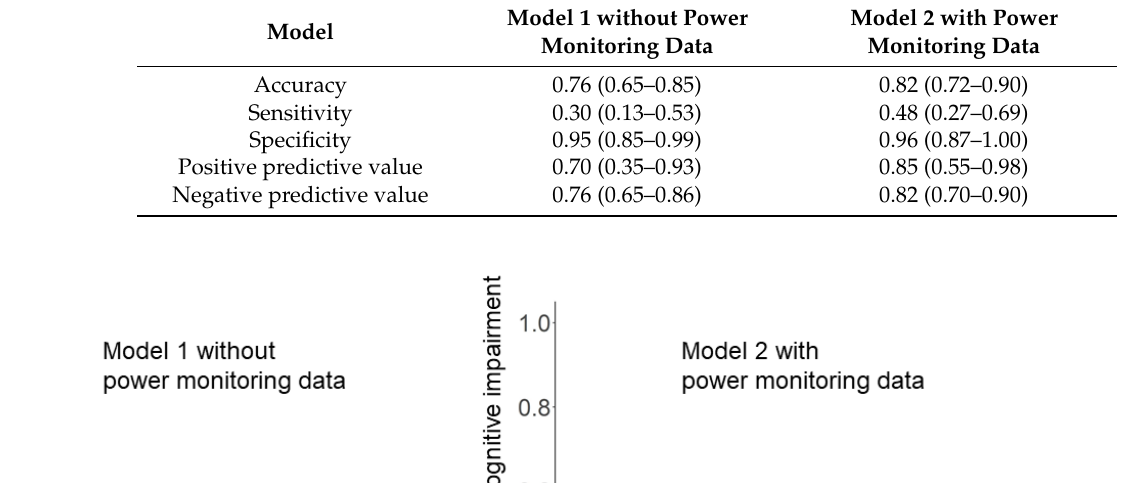
Table 2. Prediction performance of models for cognitive impairment with and without in-house power monitoring data.